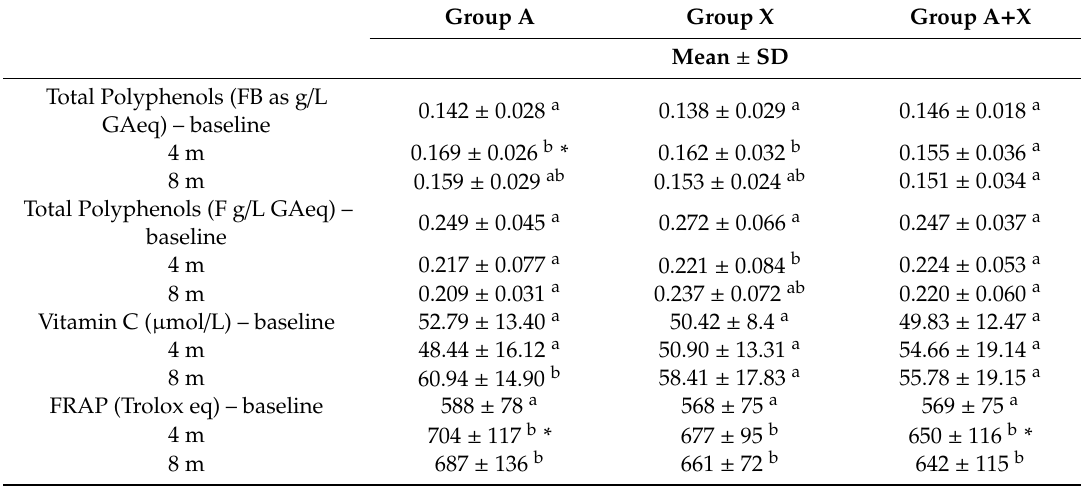
Table 2. Total polyphenols, vitamin C, and FRAP results for the three groups at the three time points (mean ±